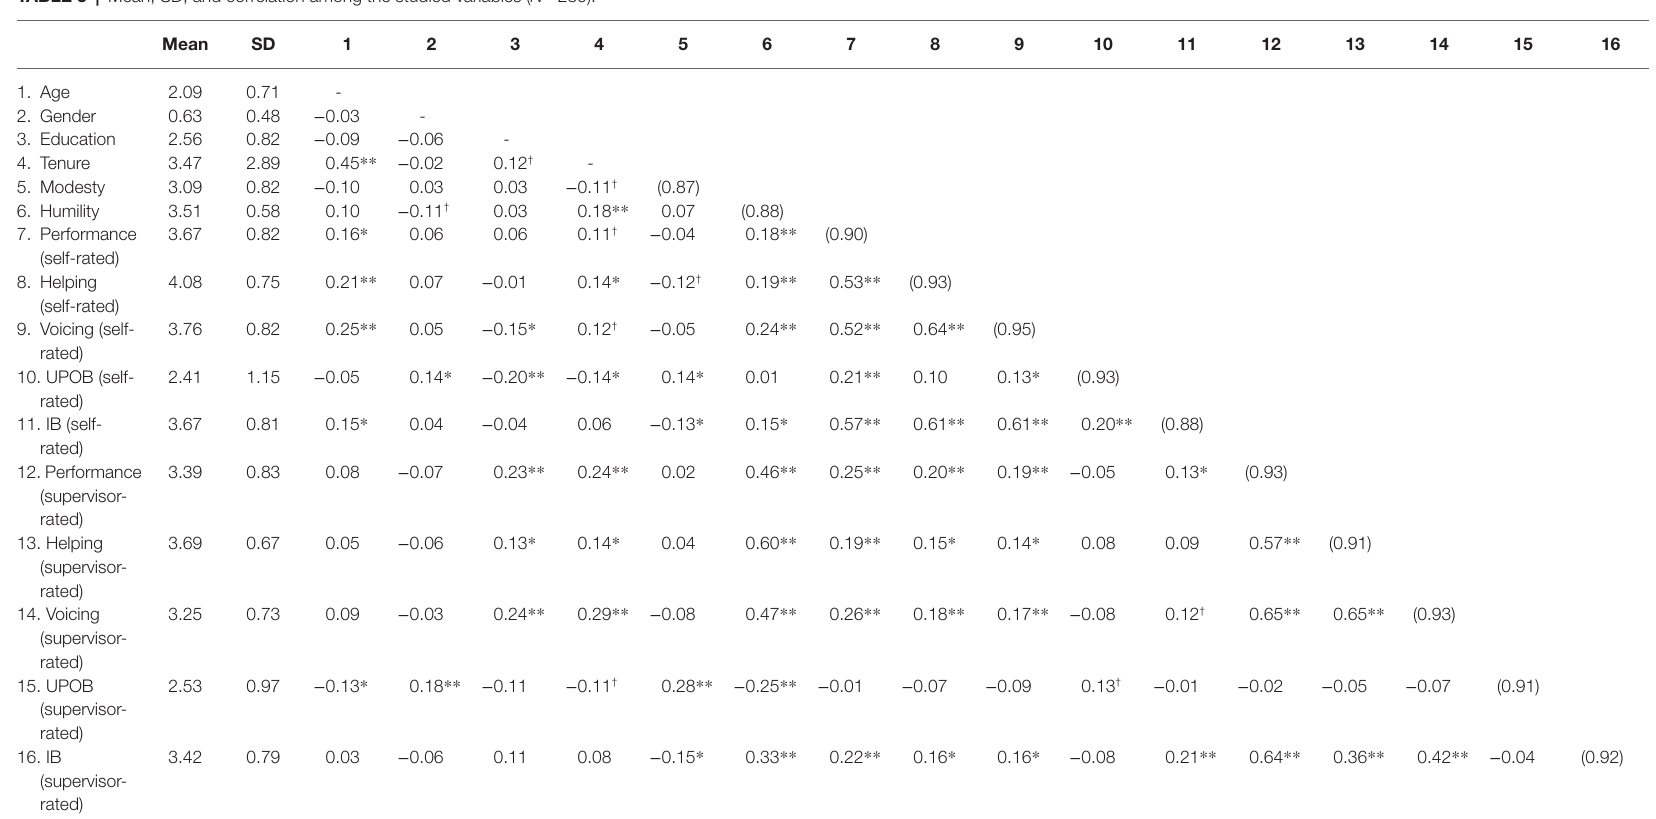
TABLE 3 | Mean, SD, and correlation among the studied variables ( N =